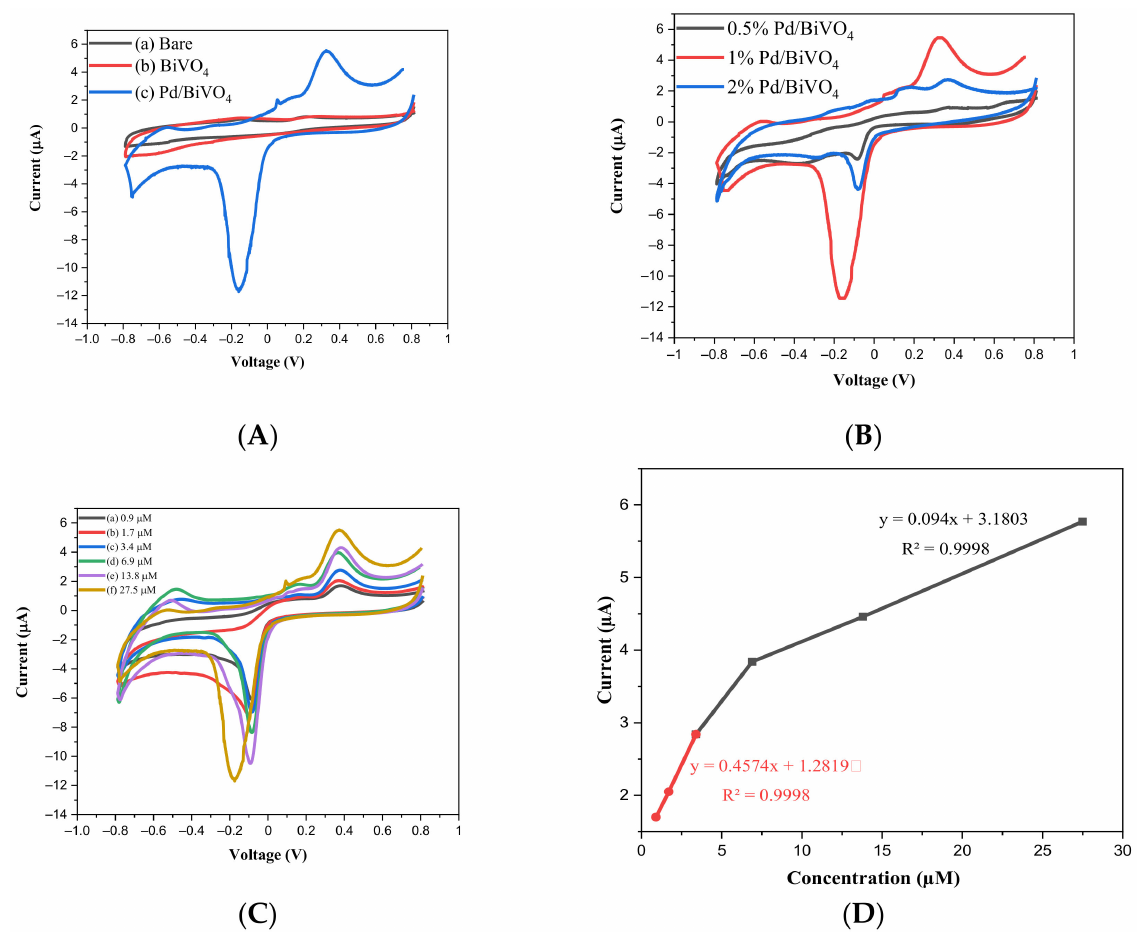
Figure 5. ( A ) CV response of (a) bare GCE (b) BiPO 4 /GCE (c) 1%Pd/BiVO 4 /GCE at scan rate of 1.0 mVs − 1 ; ( B ) CV response of 27.5 µ M epinephrine at Pd/BiVO 4 /GCE with various Pd amounts; ( C ) CV response at 1%Pd/BiVO 4 /GCE with various epinephrine concentrations (a) 0.9 µ M (b) 1.7 µ M (c) 3.4 µ M (d) 6.9 µ M (e) 13.8 µ M (f) 27.5 µ M; ( D ) The plot of I pa against various epinephrine concentrations at 1%Pd/BiVO 4